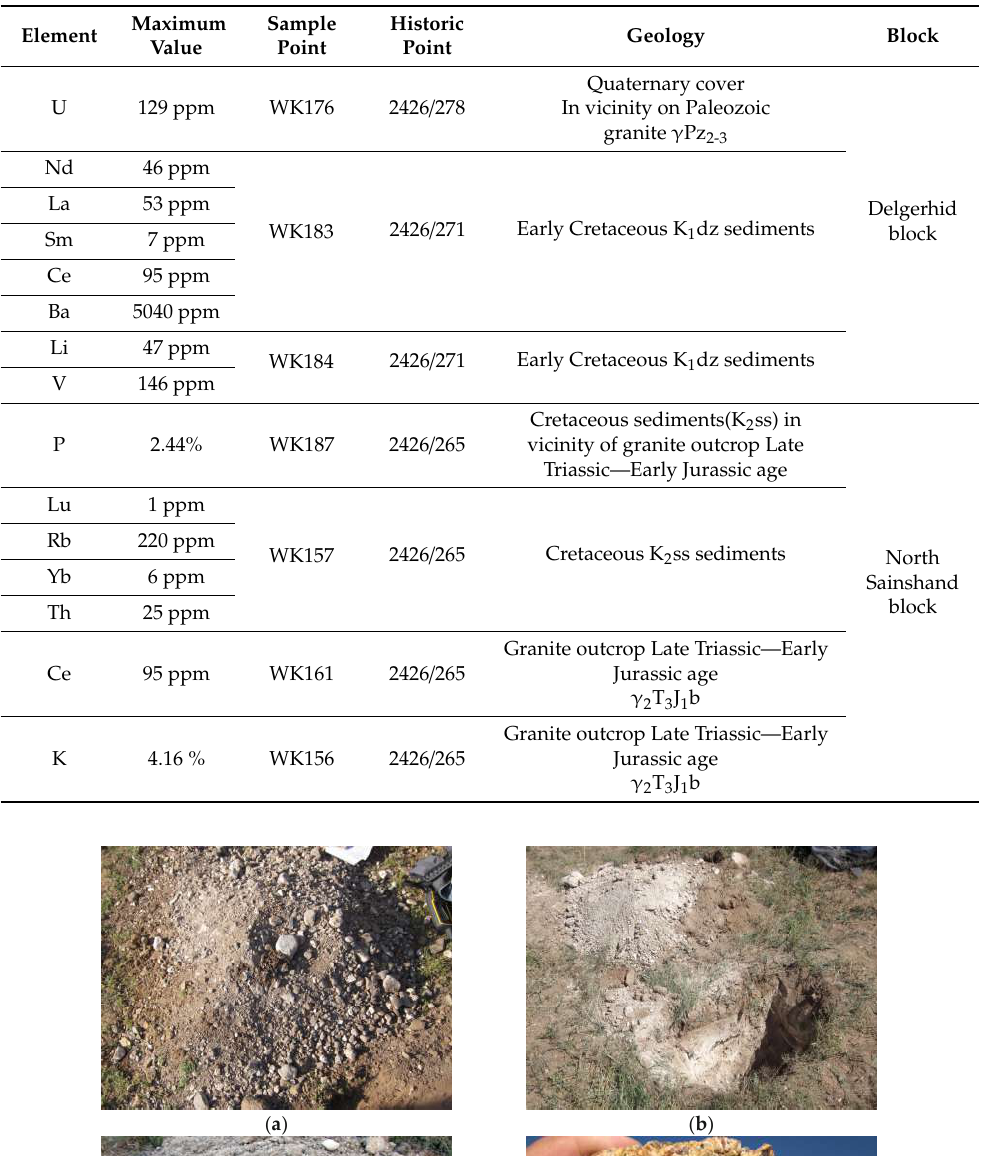
Table 1. The highest values determined from sample points and areas.